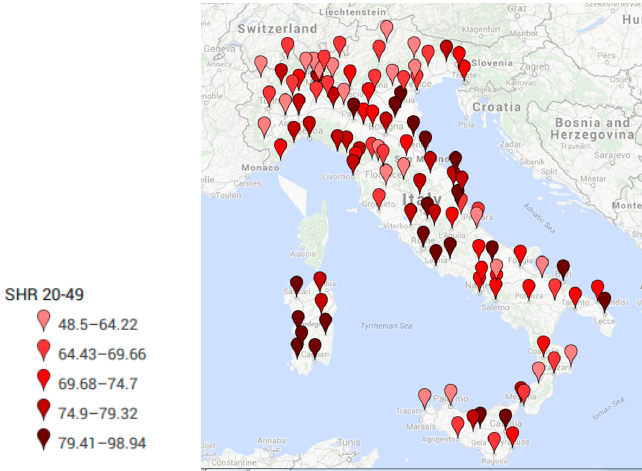
Figure 3. Standardized Hospitalization Rate (SHR) per 100,000 inhabitants per each Italian province due to main diagnosis of cancer (all tumors) in adults aged 20–49 years old.